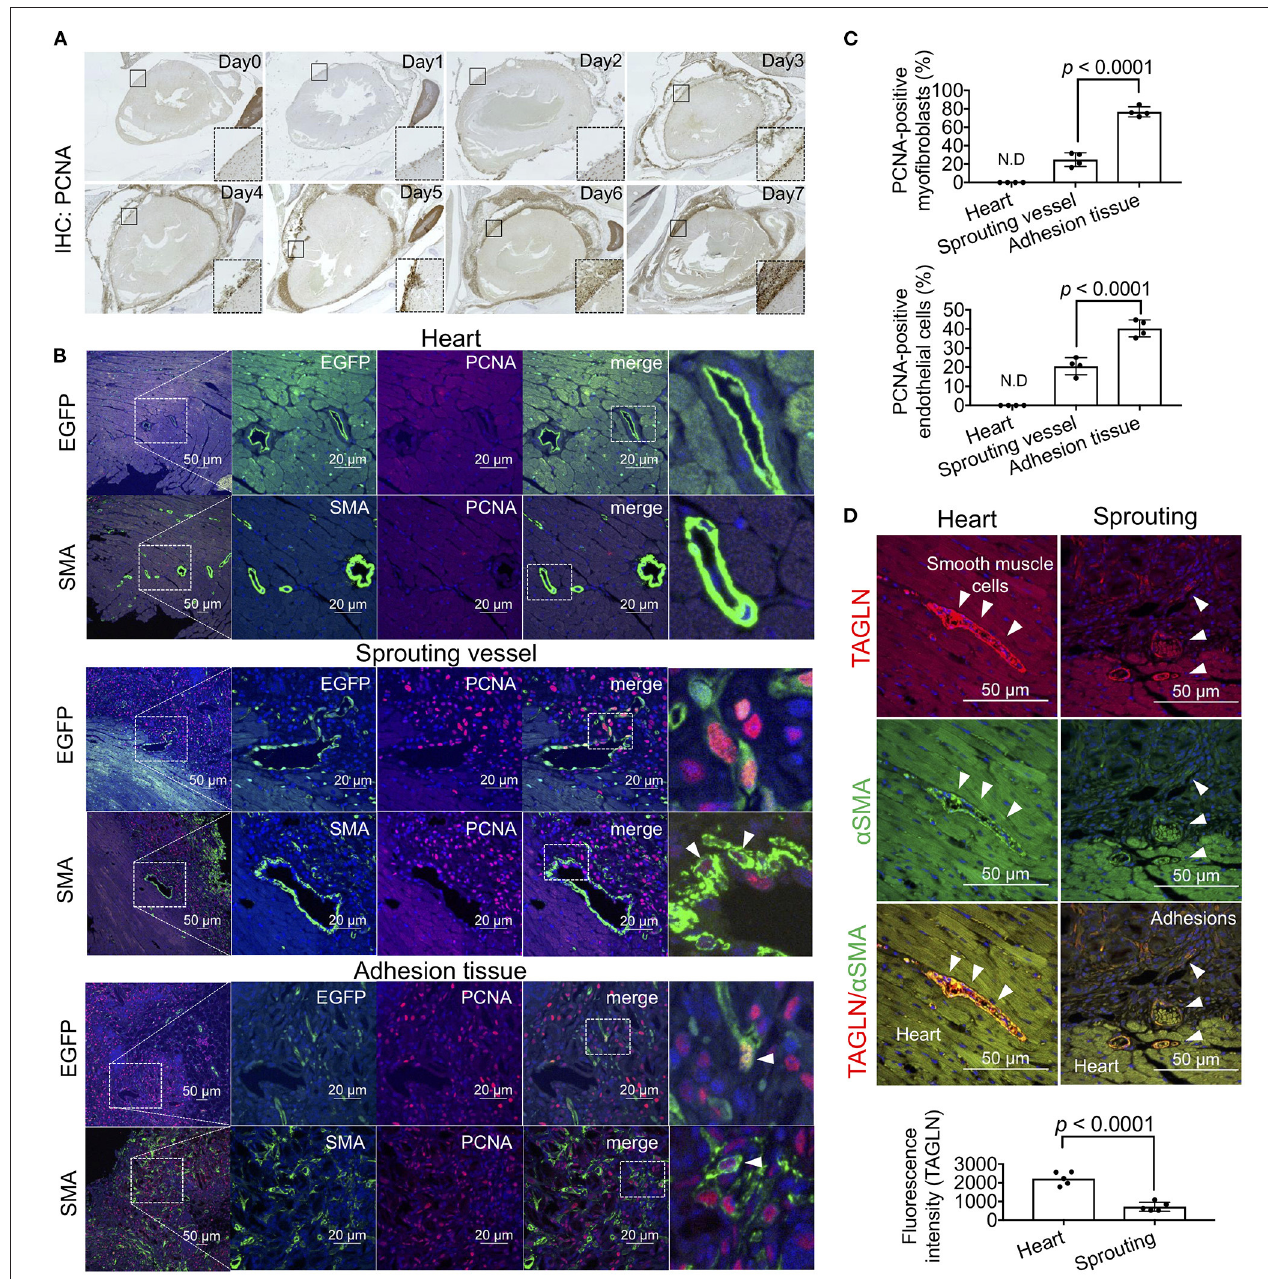
FIGURE 5 | Cell growth of myofibroblasts and endothelial cells during adhesion formation. (A) The sagittal section of the chest cavity after immunohistochemistry (IHC) with anti-PCNA antibodies. The areas surrounded by broken lines indicate magnified images of the areas surrounded by solid lines. (B) Tissue localization of PCNA-positive endothelial cells and myofibroblasts within the myocardial tissues, sprouting vessels, and adhesion tissues. The rightmost panels include enlarged views of the areas surrounded by broken lines in the second panel from the right. Arrowheads indicate PCNA-positive cells. Scale bar = 20 µ m. (C) Quantitative analysis of PCNA-positive myofibroblasts and endothelial cells in the heart, sprouting vessels, and adhesion tissues ( n = 4). Data are presented as means ± SE. Statistical analyses were performed using a two-tailed t -test (parametric variables). (D) Immunohistochemical co-staining of α SMA and TAGLN of arterioles in heart tissue and sprouting vessels (upper). Arrowheads indicate TAGLN-positive smooth muscle cells. Quantification of TAGLN-derived fluorescence intensities of arterioles in the heart and sprouting vessels using NIS-Elements software. Data are presented as means ± SE. Statistical analyses were performed using a two-tailed t -test (parametric